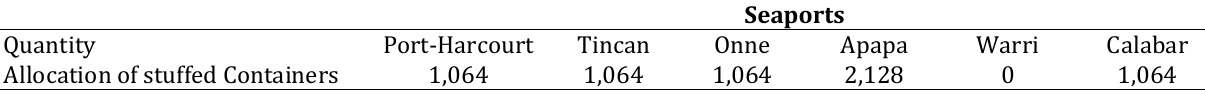
Table 12: Optimal allocation